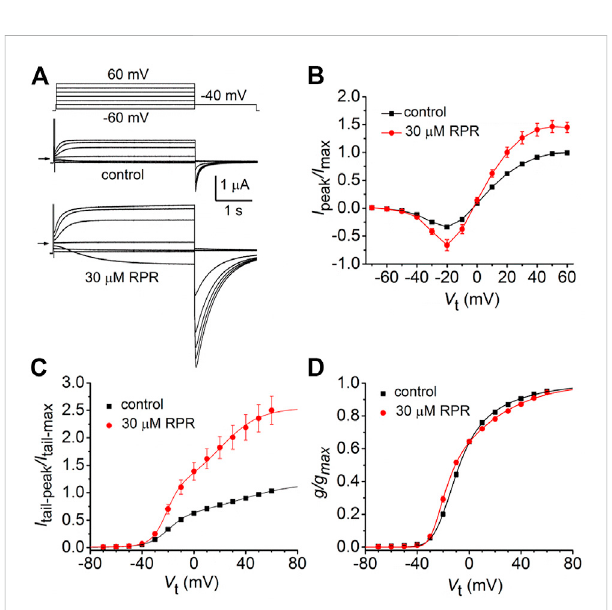
FIGURE 2 Effects of 30 µM RPR on split hERG1a channel currents. (A) Voltage clamp protocol and corresponding split hERG1a currents recorded from an oocyte before (control) and after treatment with 30 µM RPR. Oocyte was bathed in high K + (104 mM) extracellular solution. Horizontal arrow indicates zero current level. (B) Effects of RPR on normalized I peak -V relationship. Currents were increased by RPR ( n = 7); p < 0.0001, 2 way ANOVA). (C) RPR increases the magnitude of I tail-peak ( n = 7; p < 0.0001, 2-way ANOVA). Currents were normalized relative to I tail-max under control conditions. (D) G-V relationships. Averaged data from panel C were normalized relative to fi tted to a 6-state model of channel I tail-max under each condition and gating (smooth curves) as described in the Methods. Parameters for modelundercontrolconditionswere: z 1 =1.71, z 2 =0.73, K (0)=0.155, z K (0) = 0.023, K o (0) = 0.32; in the presence of RPR: z 1 = 2.98, 2 = 0.81, K o (0) =